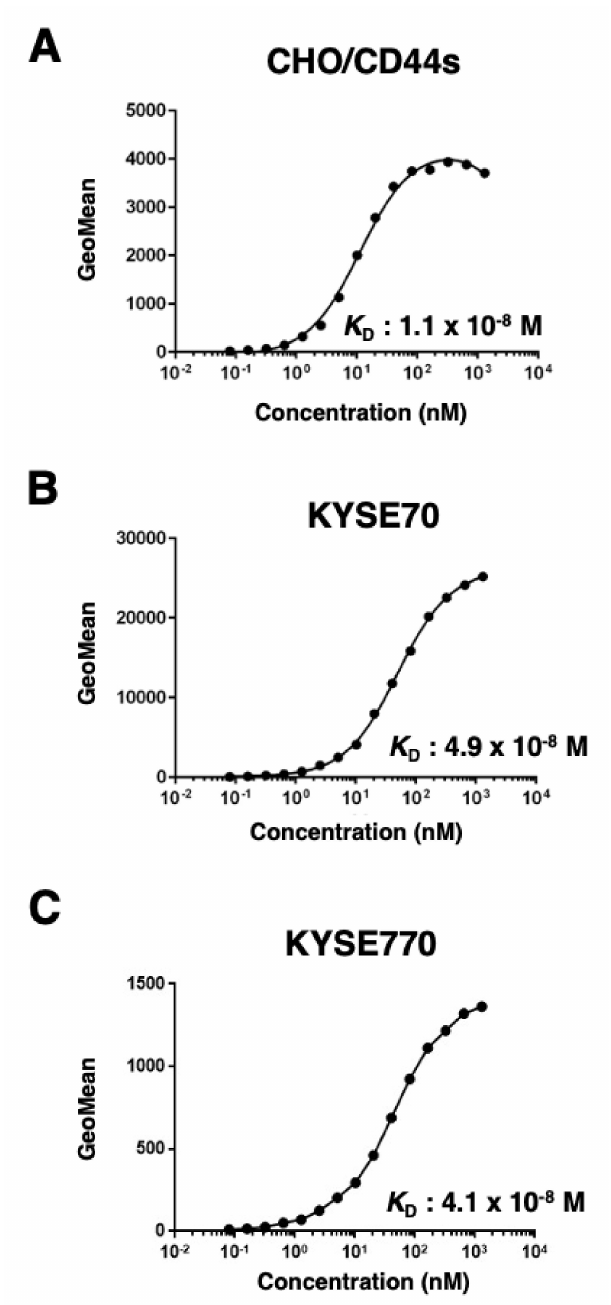
Figure 3. The determination of the binding affinity of C 44 Mab − 46. CHO/CD44s ( A ), KYSE70 ( B ), and KYSE770 ( C ) cells were suspended in 100 µ L serially diluted C 44 Mab − 46 (0.08 to 1300 nM). Then, cells were treated with Alexa Fluor 488 − conjugated anti − mouse IgG. Fluorescence data were subsequently collected, followed by the calculation of the apparent dissociation constant ( K D ) by GraphPad PRISM